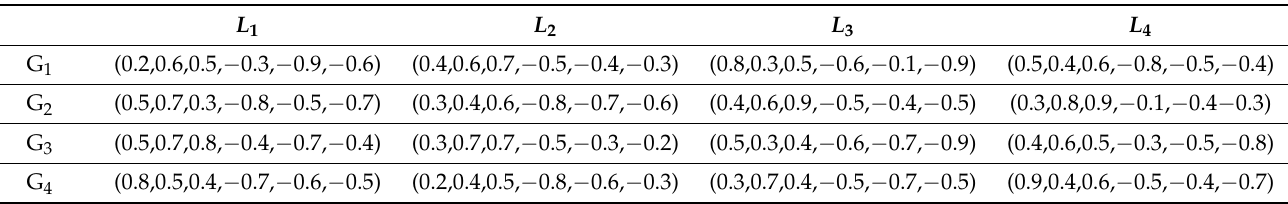
Table 1. BN decision matrix by decision-maker D 1 .